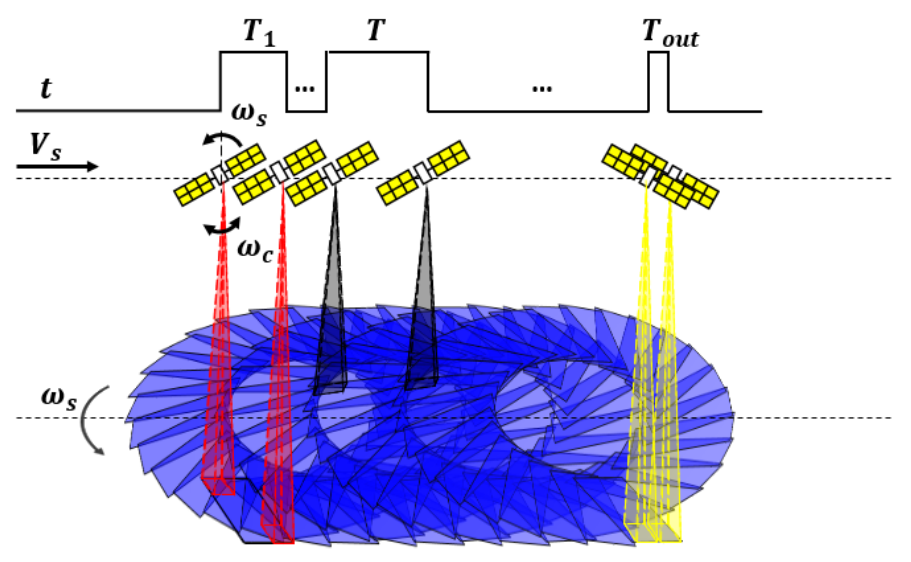
Figure 3. Illustration of an OCPSI satellite.